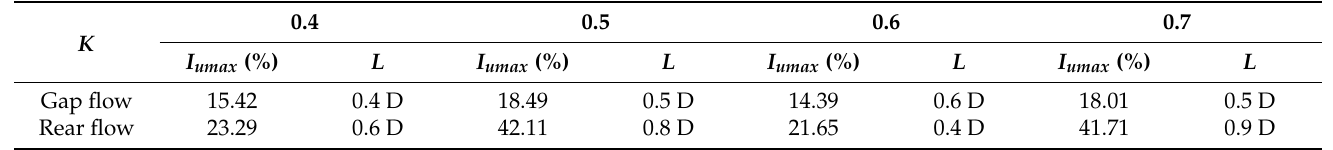
Table 3. Maximum cross-sectional average turbulence intensity and vortex formation lengths with different diameter-to-length